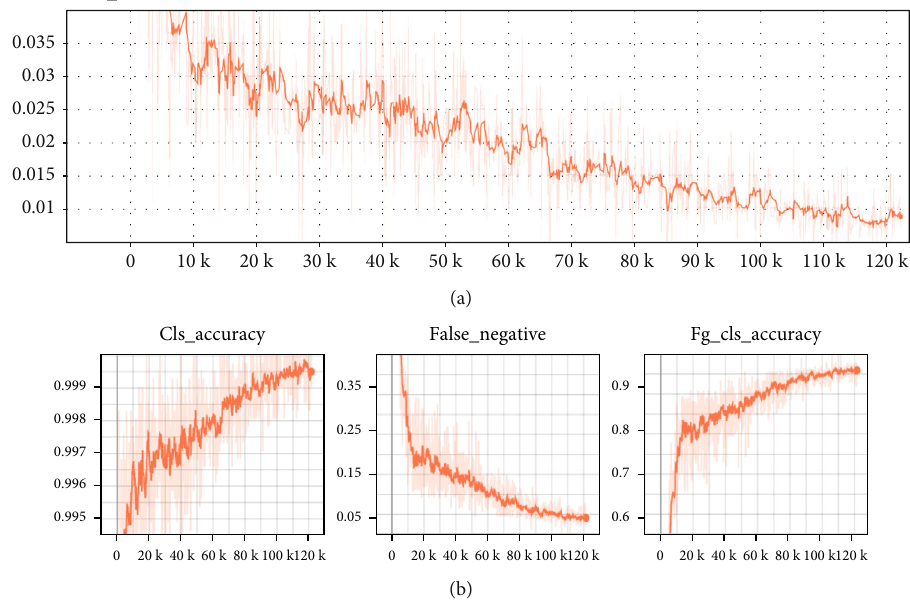
Figure 4: Training details. (a) Loss curves of training sets under di ff erent iterations and (b) variation curves of di ff erent evaluation index values of training sets under di ff erent